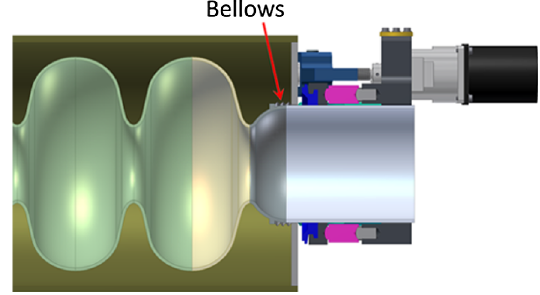
FIG. 13. One method of decreasing df=dp is reduction of the diameter of the bellows used in conjunction with the Saclay tuner. no ring